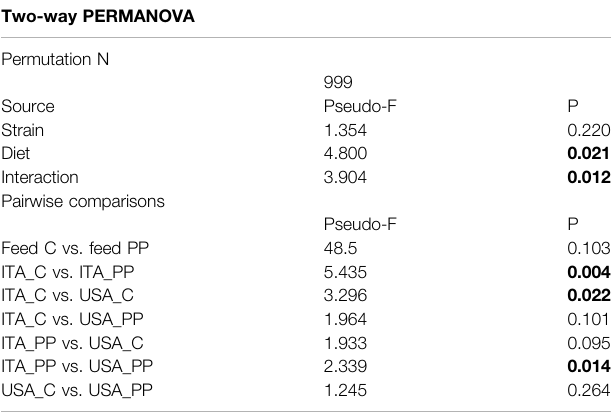
TABLE 5 | Results of non-parametric multivariate analysis PERMANOVA on the unweighted UniFrac data of intestinal and feed samples. Signi fi cant p values ( p ≤ 0.05) are in